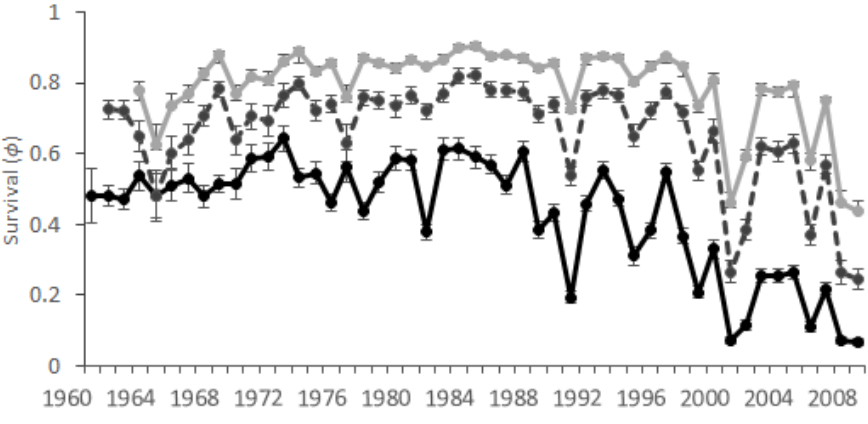
Figure 3. Survival probabilities ( φ ) for the different age classes. Juveniles <1 year (dark solid line); immatures 2–3 year (dashed line); Adult >3 year (grey line). Estimates were obtained from the best fit model (lower QAICc) in Table 2, where survival of all age classes was time-constrained by the quadratic Northern temperature anomaly and linearly constrained by the Sahel index (additive effect). The model included an additive effect on the survival of the covariates (latitude, trend in NDVI in the ringing site, mean distance to dump) and interaction terms between covariates and latitude (see Table 1). The model also included three age classes for recapture probabilities (see Table S1 in the Supplementary Materials). Recapture rates were dependent on latitude in the ringing site and followed an exponential temporal trend (additive effect, i.e., parallel slopes among age classes). Estimates were based on the average values of the individual covariates. Vertical bars indicate ± standard error.